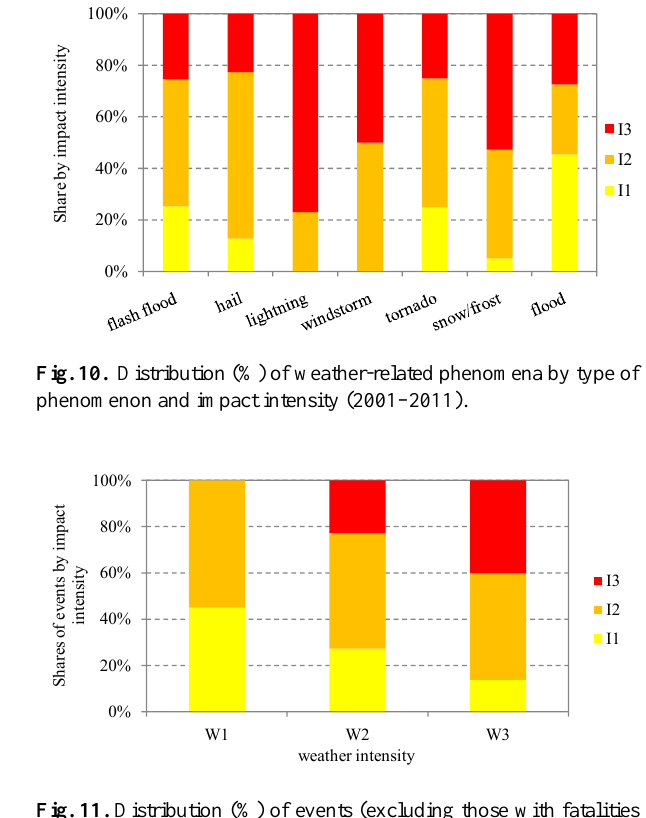
Fig. 11. Distribution (%) of events (excluding those with fatalities due to lightning) based on weather and impact intensity (2001–